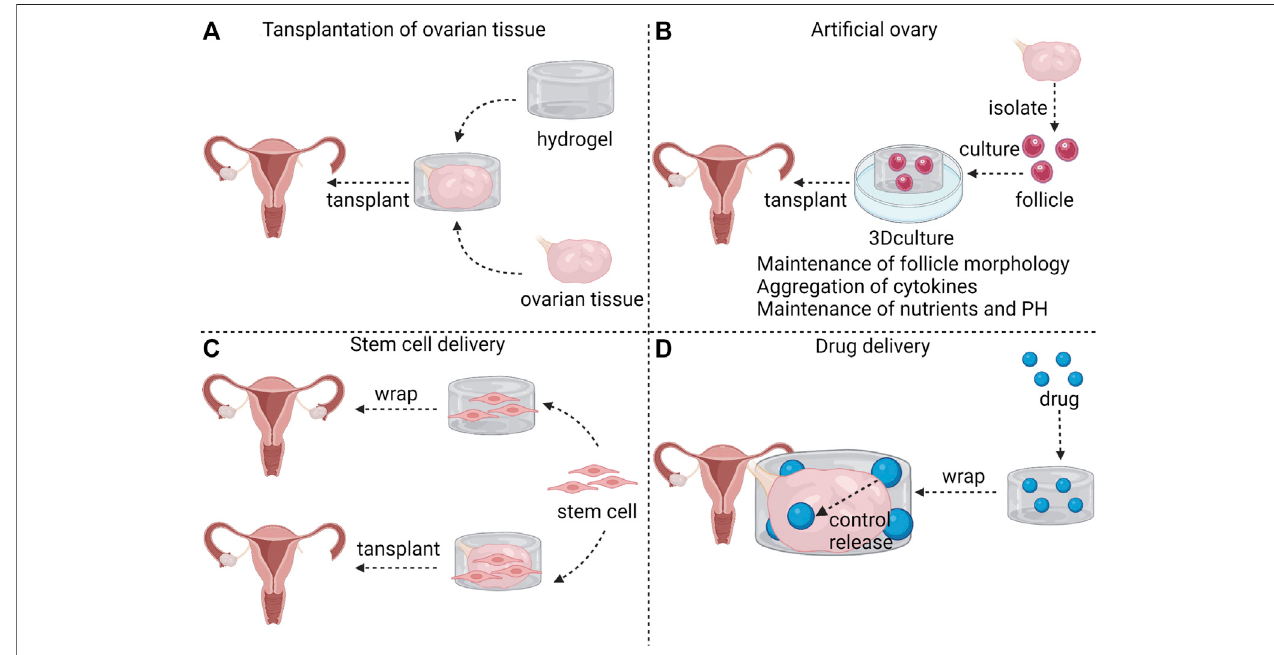
FIGURE 1 | The application of hydrogels in POF. Hydrogel can be used as a carrier for ovarian tissue transplantation (A) . Hydrogel 3D culture is characterized by maintenanceoffolliclemorphology,aggregationofcytokinesandmaintenanceofnutrientsandPH;thus,hydrogelcanbeusedasamaterialforarti fi cialovaries (B) .Stem cells can be encapsulated in hydrogel to wrap ovaries in POF patients to exert therapeutic effects; Stem cells can also be encapsulated in hydrogel along with ovarian tissues for ovarian transplantation (C) . Hydrogels surrounding ovaries control the rate of drug release (D) .